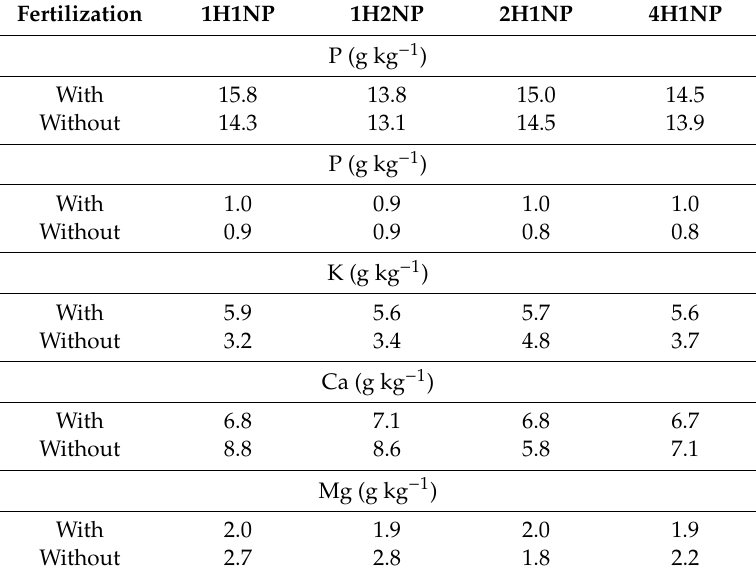
Table 6. Contents of N, P, K, Ca and Mg in the leaves of the clone GG157, at 60 months of age, in response to liming / fertilization (With or Without) and height (H) and number (NP) of poles per stump at the time of pole